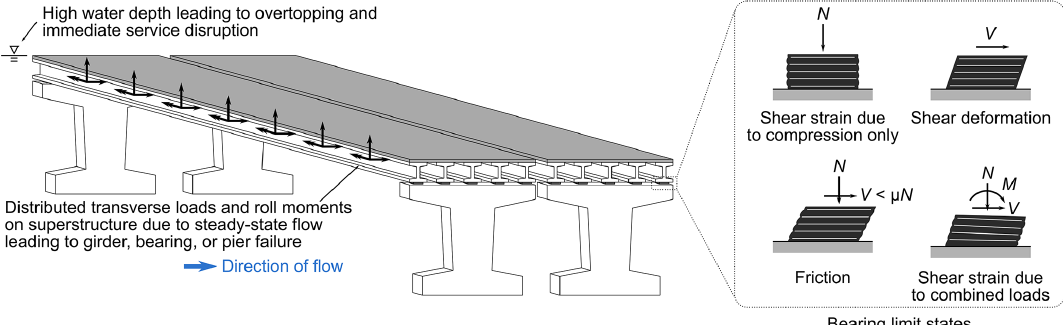
Figure 2. Bridge failure states investigated due to flood